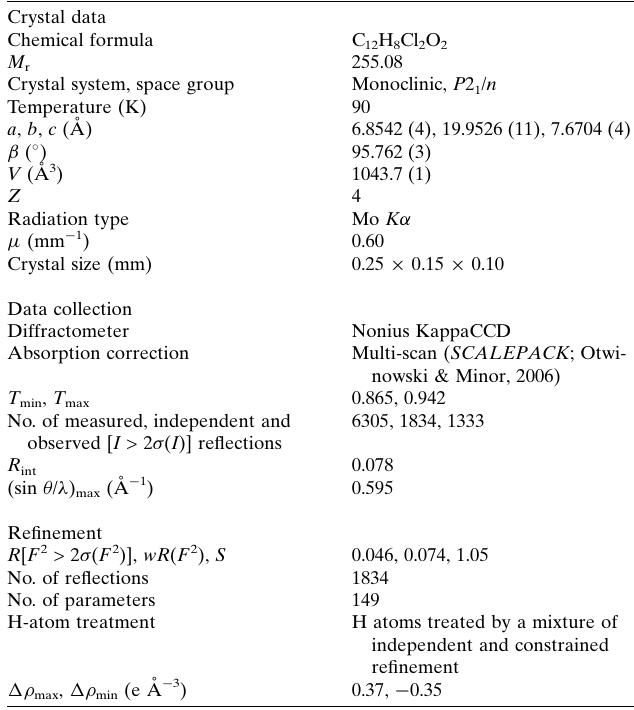
Table 1 Hydrogen-bond geometry (A˚ , (cid:3) ).